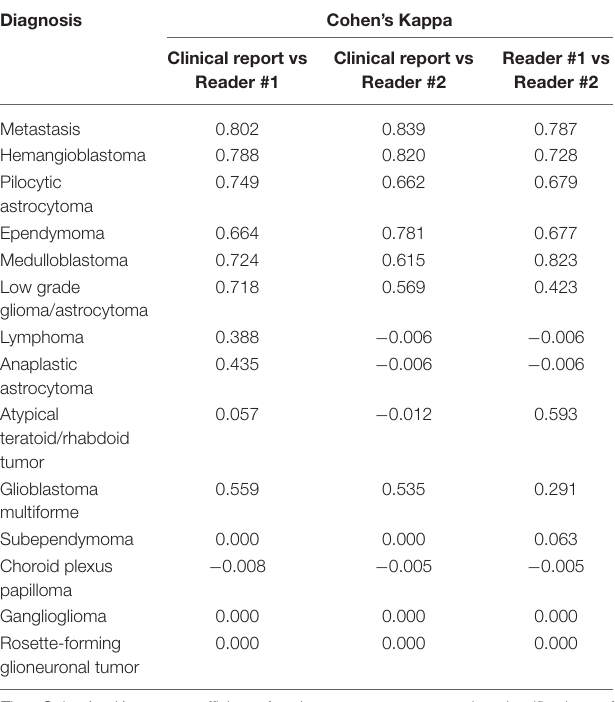
TABLE 4 | Inter-rater agreement in differentiation of posterior cranial fossa